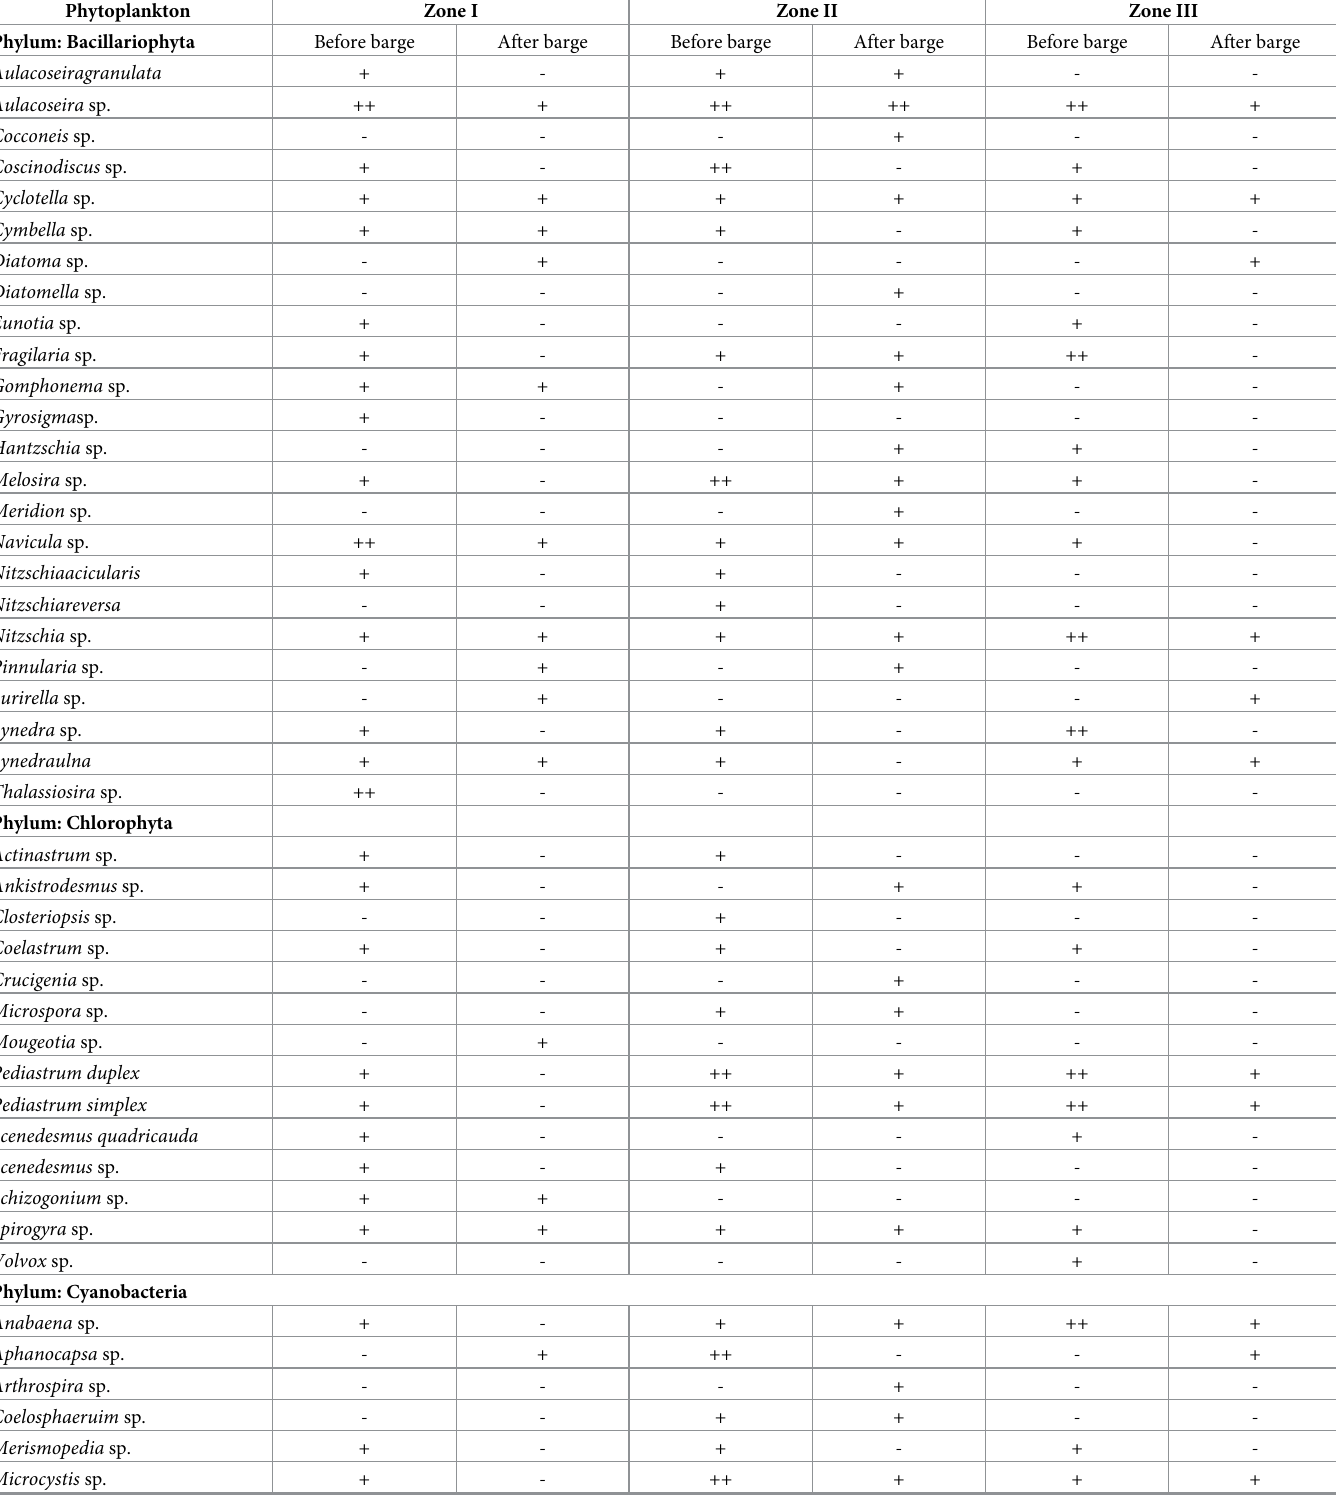
Table 1. Zone wise phytoplankton diversity. Phytoplankton Phylum: